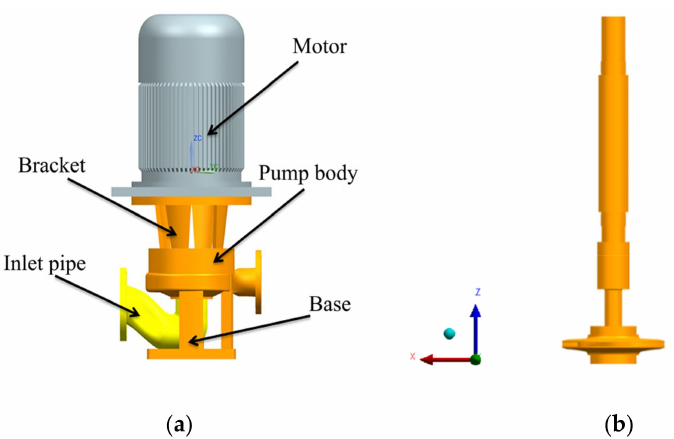
Figure 4. The three-dimensional (3D) model of the pump unit: ( a ) pump unit structure; ( b ) rotor system.